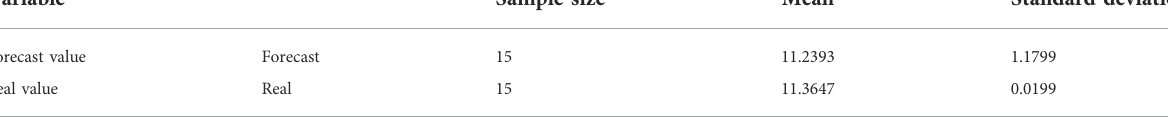
TABLE 4 Paired t -test results.